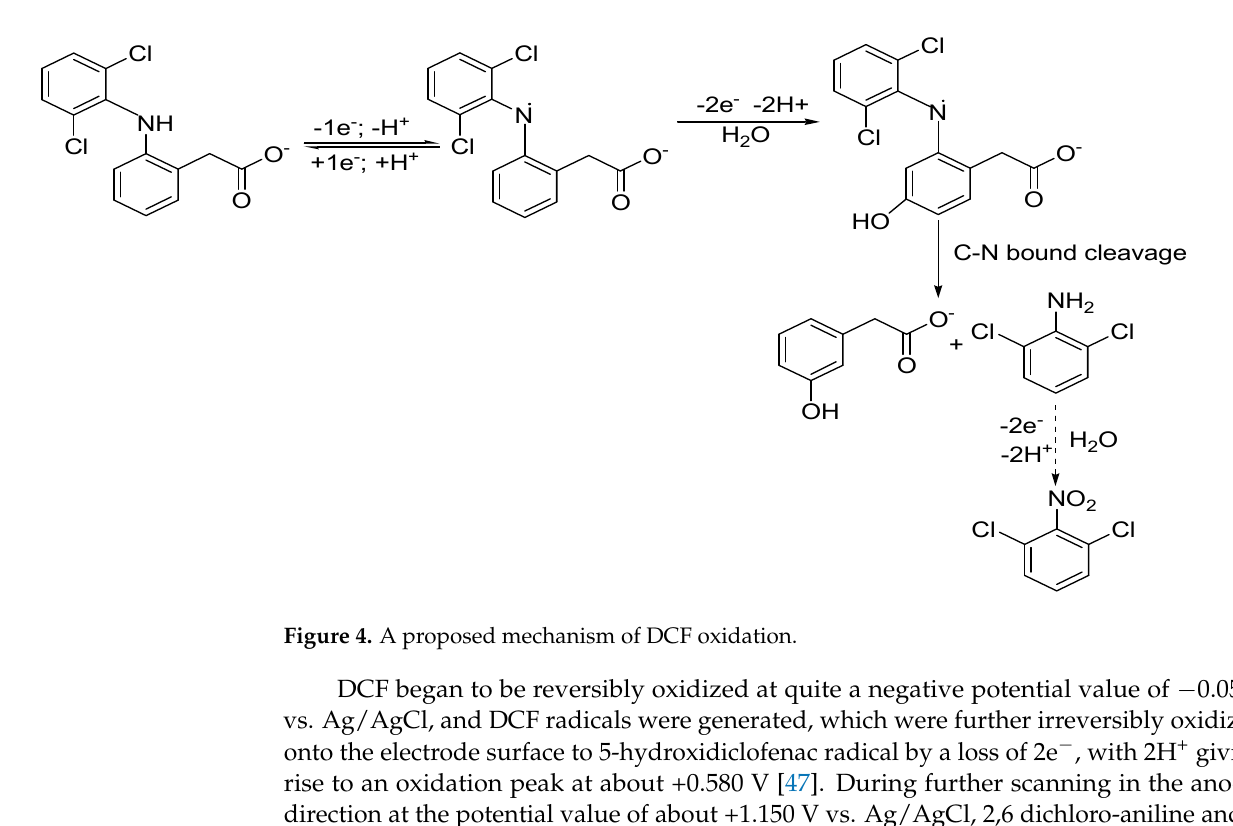
Figure 4. A proposed mechanism of DCF oxidation.